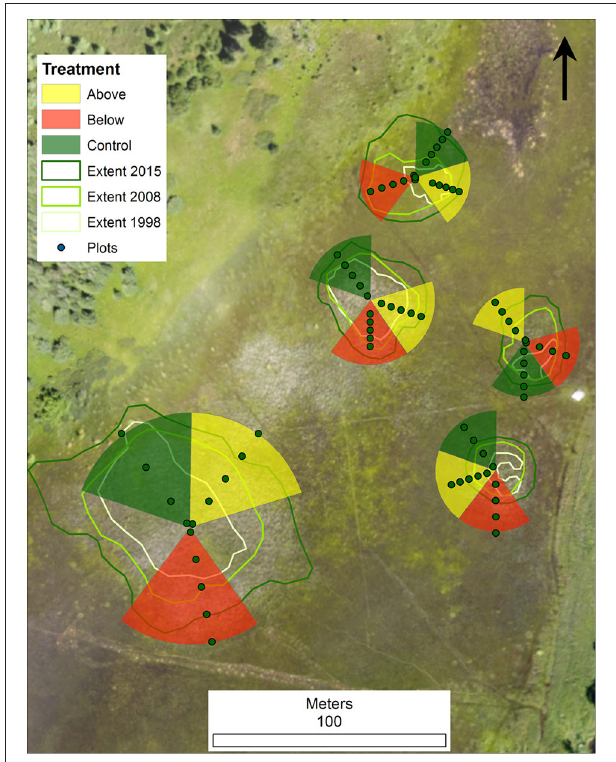
FIGURE 2 | Plot layout at Sand Island, MI illustrating five isolated Typha stands, completely randomized block design, vegetation sampling transects, vegetation subplots, and the extent of Typha at three points in time (1998, 2008, and